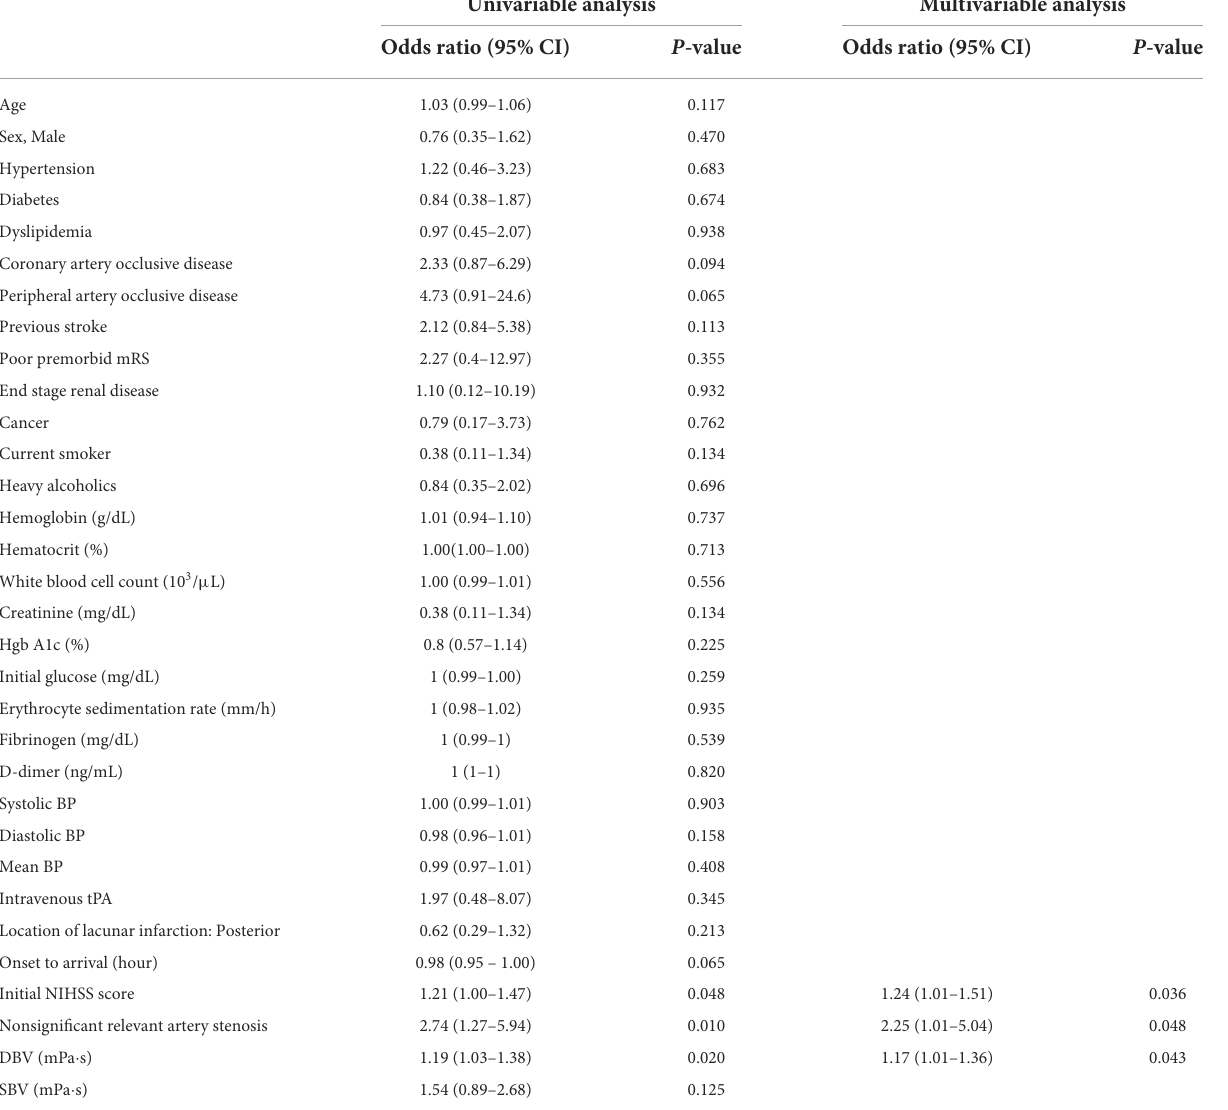
TABLE 2 Univariable and multivariate logistic regression analyses for early neurologic deterioration. Univariable analysis Multivariable